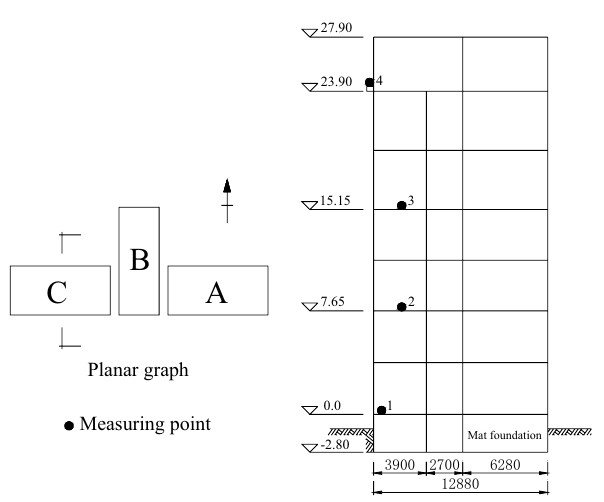
Figure 3. Section and measuring point layout of the building